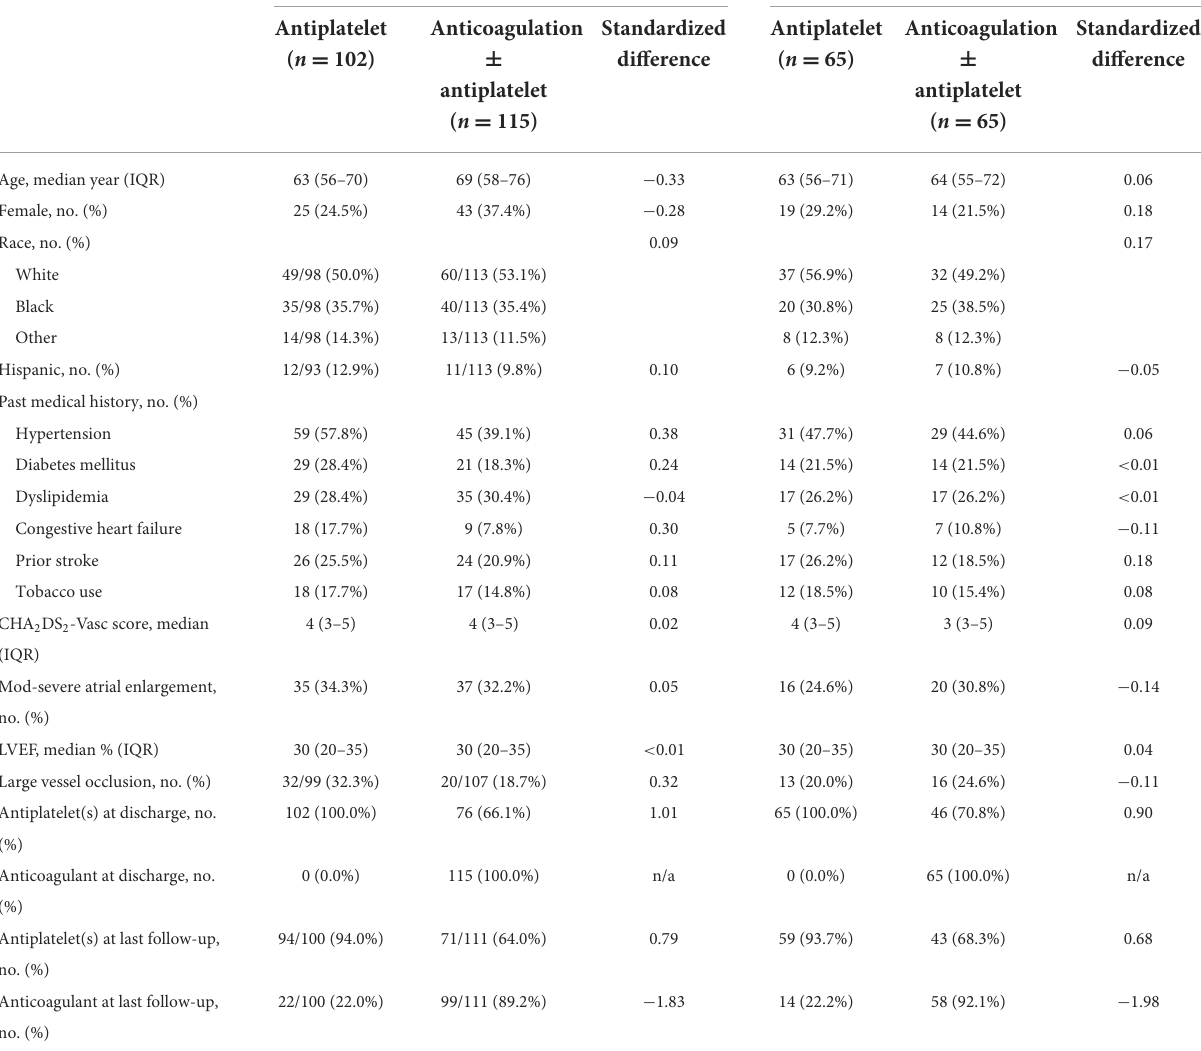
TABLE 1 Demographics according to intention-to-treat principle.